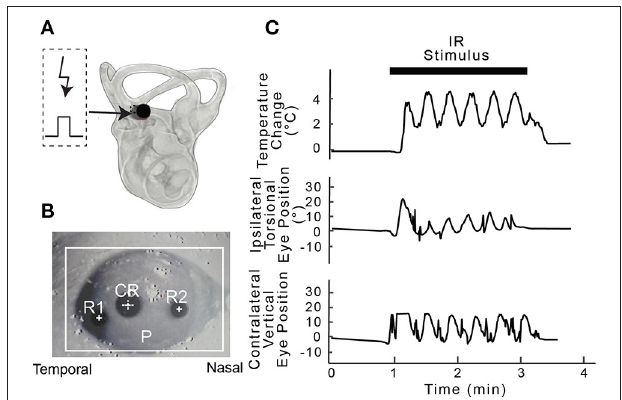
FIGURE 1 | Experimental setup. (A) Shows an example post-mortem microtomography image of the right inner ear of a rat with a 400 µ m optical fiber (solid circle) used for IR stimulation targeting the PC ampulla. A micro thermistor (dotted circle) was inserted beside optical fiber and used to measure the change in temperature along the beam path during posterior canal stimulation. (B) Eye recording setup highlighting pupil (P), cornea reflection (CR) and rotational marks (R1 and R2) was used to calculate the magnitude of the movement during IR stimulation. (C) Simultaneous physiological recordings were carried out during each 2-min IR stimulation period. The panels show IR stimulation of the vestibular end organs at 0.5Hz, the change in temperature along the beam path ( ◦ C), and frequency-matched ipsilateral torsional and contralateral vertical eye position change ( ◦ ) from IR stimulation of the PC in one